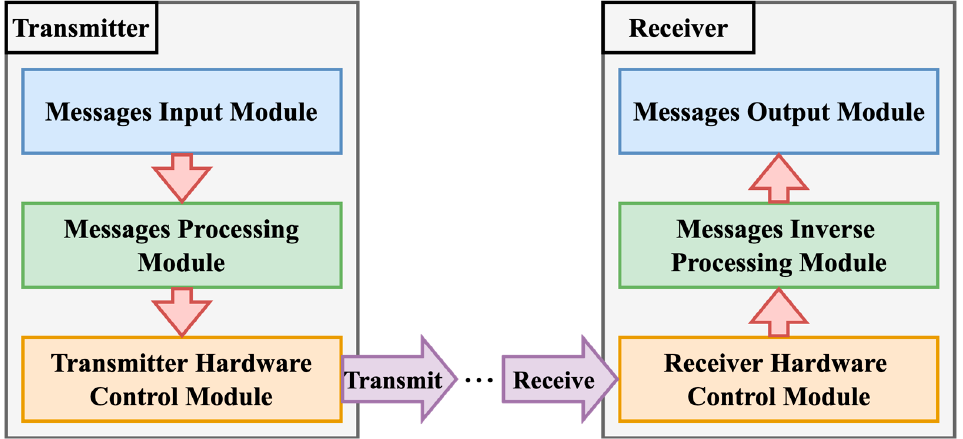
Figure 5. The software architecture of the speech communication system.